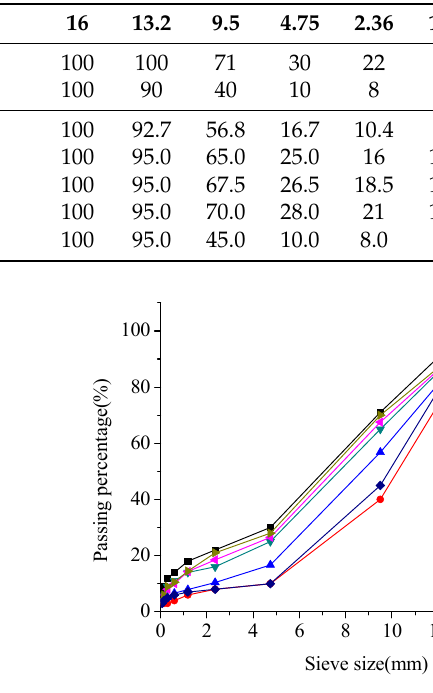
Figure 2. Gradation of PAC13 asphalt mixture.